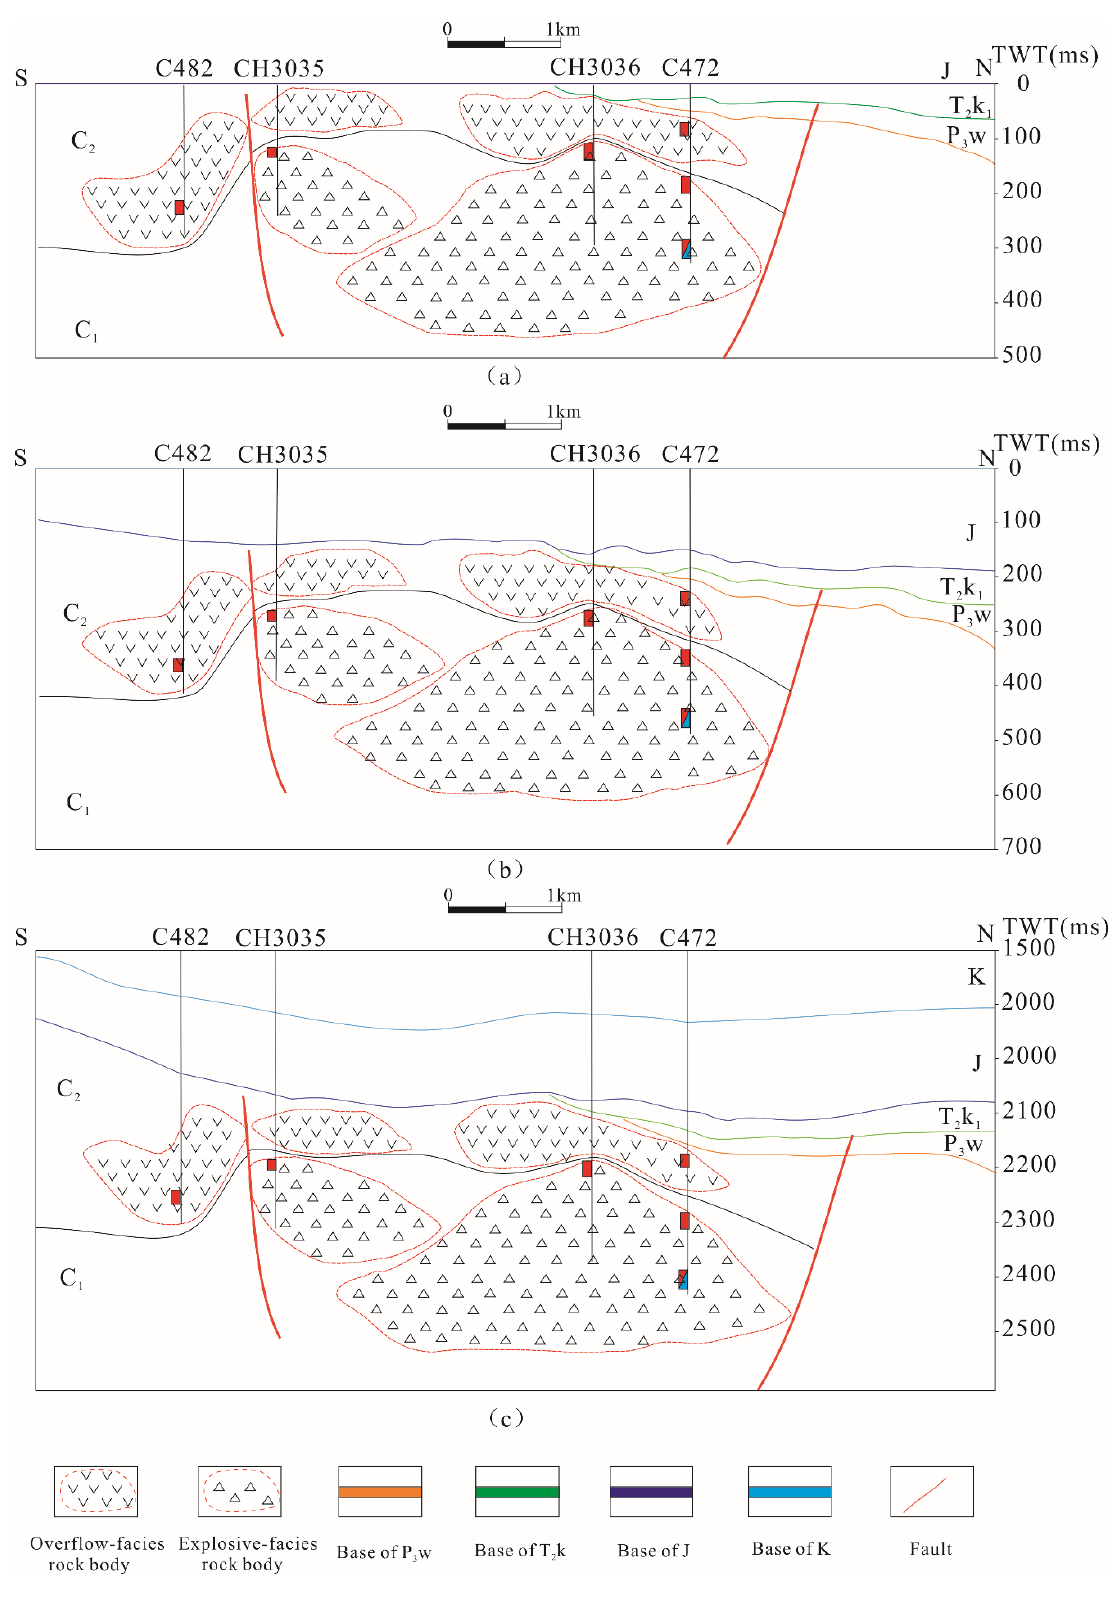
Figure 7. S-N profiles cross Wells C482-C472 in the Chepaizi Uplift, showing structural evolution. ( a ) The structural section of the flattening the Jurassic formation ; ( b ) The structural section of the flattening the Cretaceous formation ; ( c ) The present structural section.